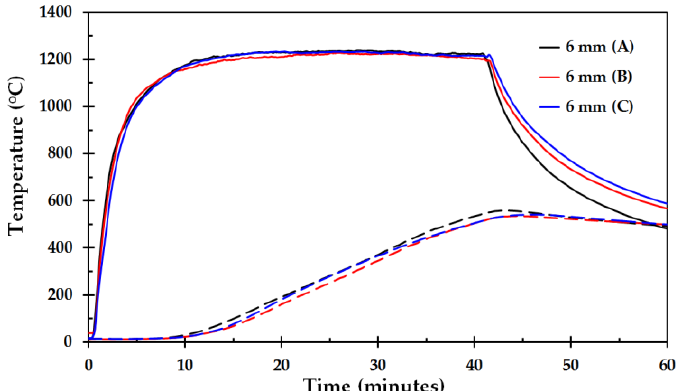
Figure 5. Temperature as a function of time for 3 mm thick steel plate, test A, B and C. Solid lines represent the plate thermometer temperature while the dashed lines represent the temperature of the exposed steel plates.